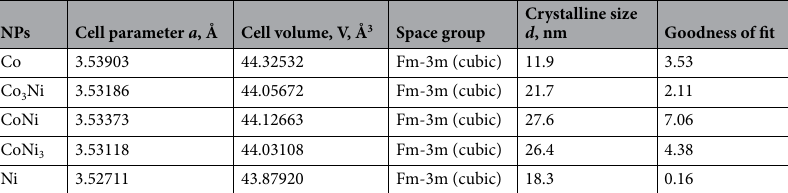
Table 1. Calculated crystalline cell parameters and crystalline sizes of the Co- and Ni-containing nanopowders.